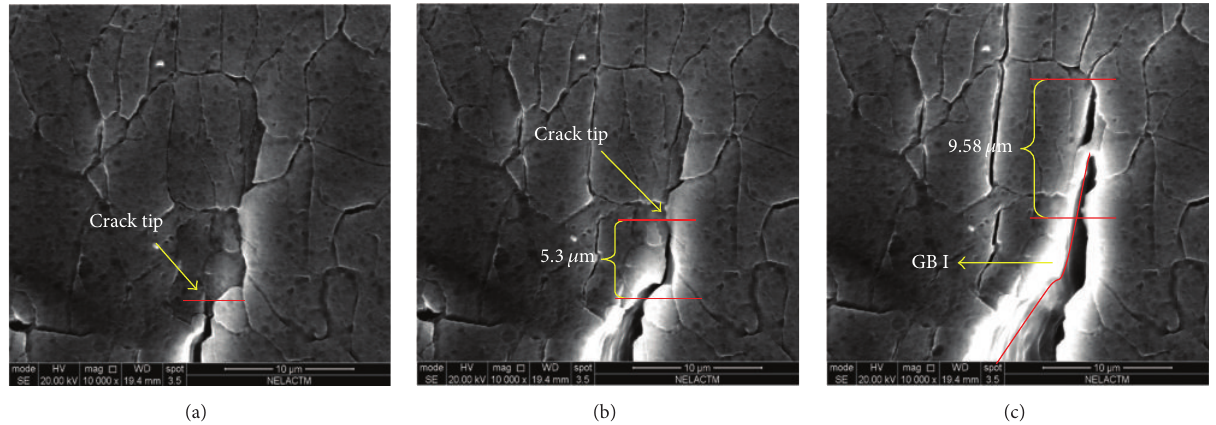
Figure 3: Micromorphology of fatigue crack: (a) at 40 cycles, (b) at 50 cycles, and (c) at 65 cycles.